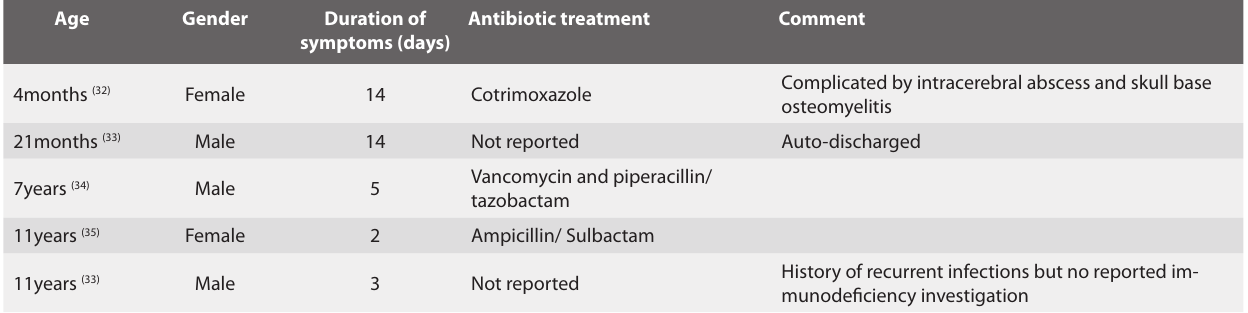
Table 1. Reported cases of paediatric spontaneous NSA.